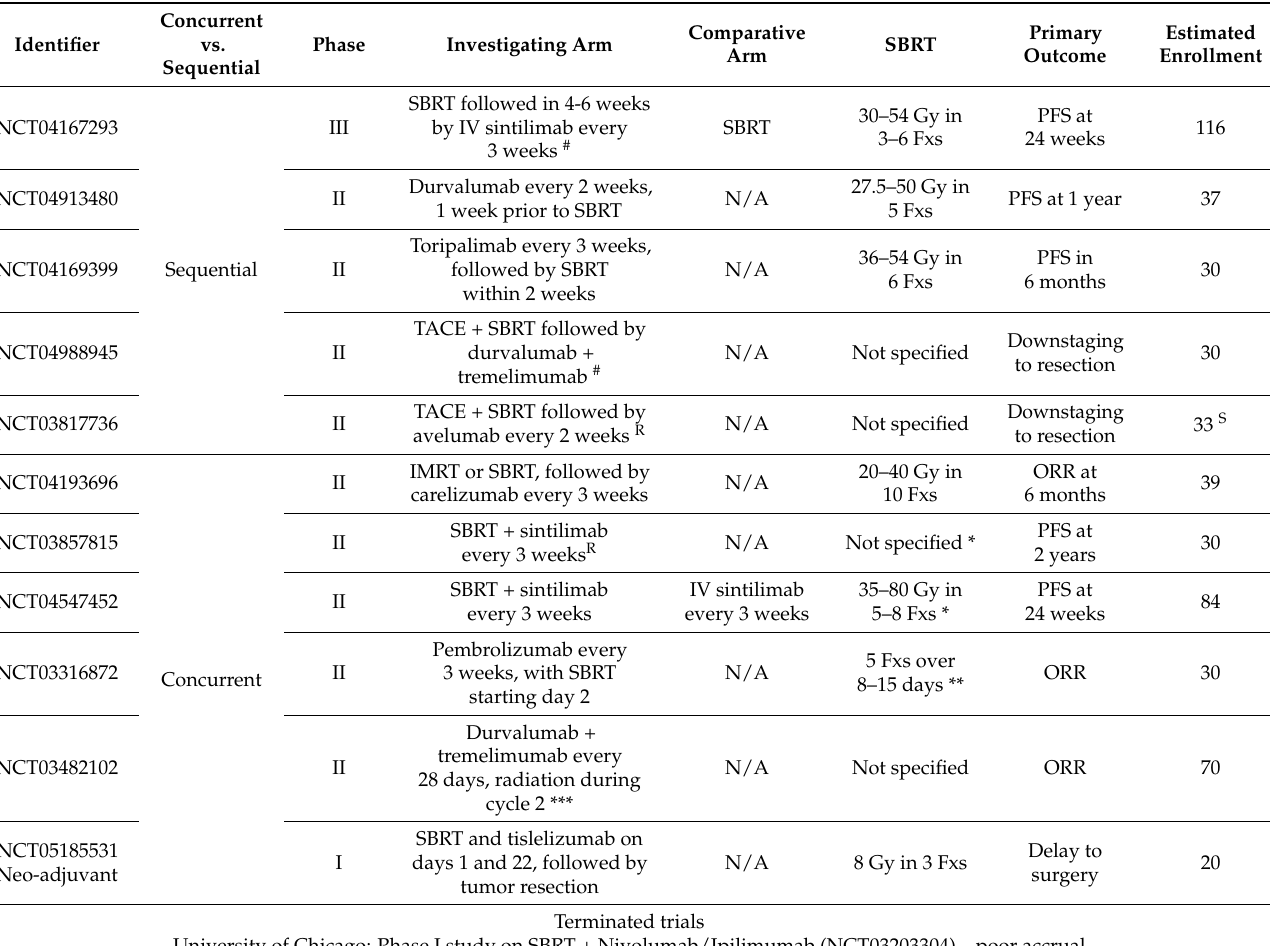
Table 2. Active Trials for Stereotactic Body Radiation Therapy and Immune-Checkpoint Inhibitors in Hepatocellular